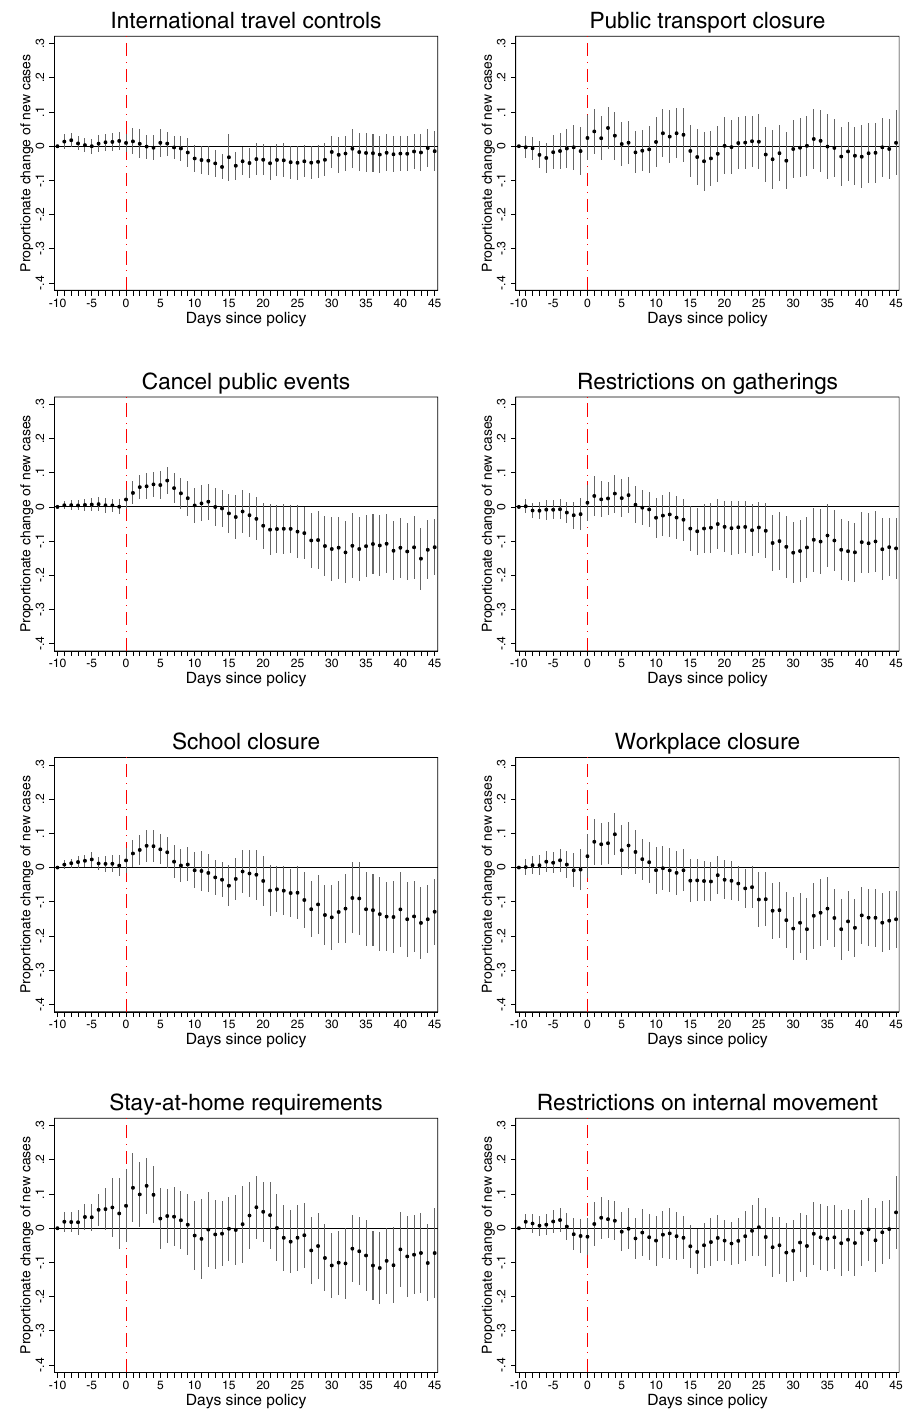
Figure 1. Effects of lockdown policies on COVID-19 confirmed new cases (3-day moving average, in logs) with controls for concurrent